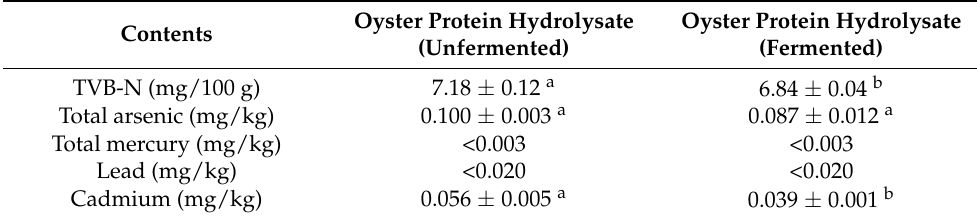
Table 4. TVB-N and heavy metal content in oyster protein hydrolysate.